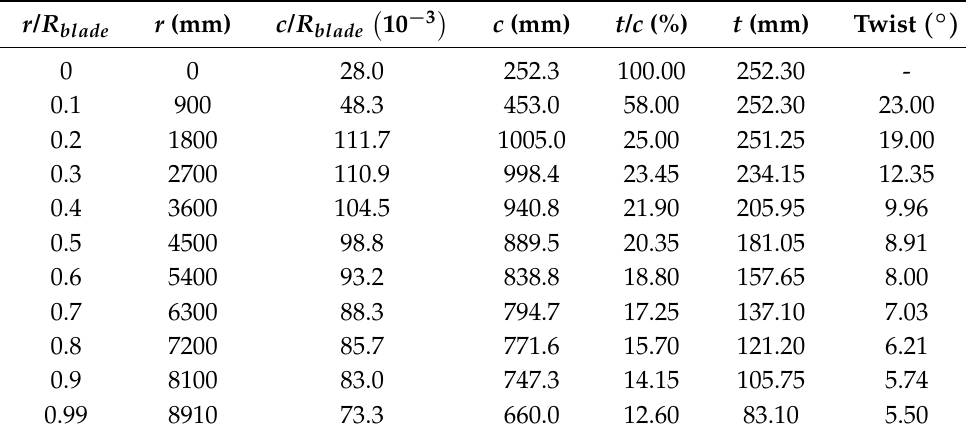
Table 1. Blade dimensions based on NACA 63-8XX profile